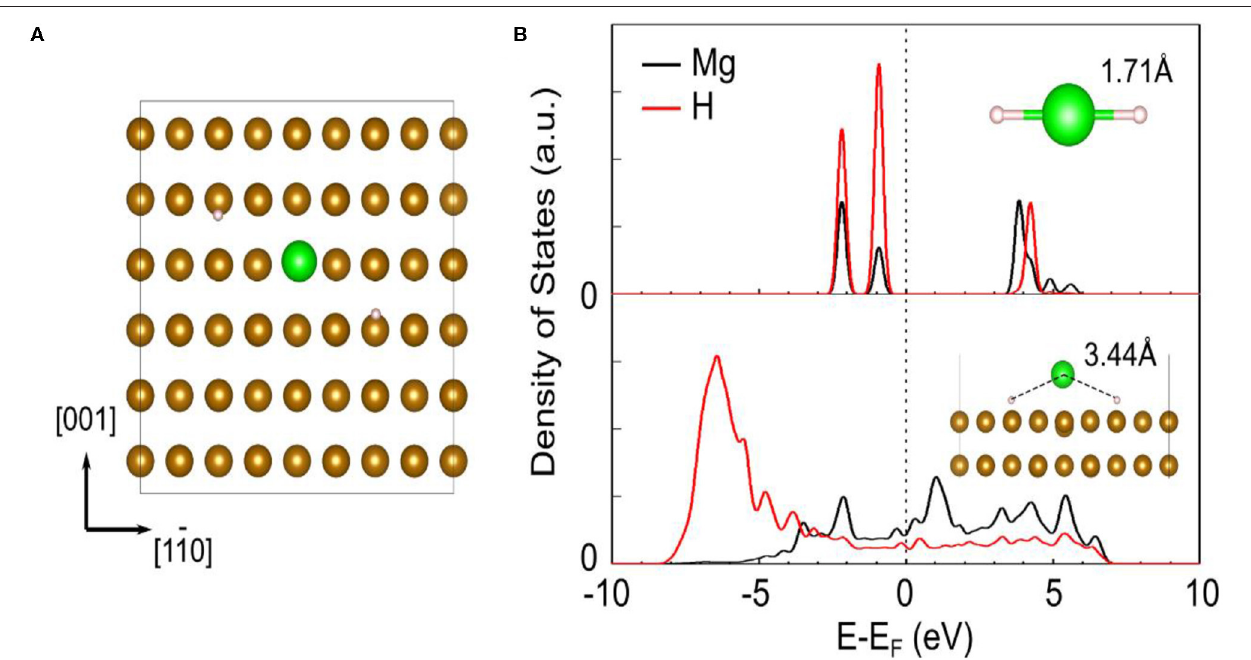
FIGURE 1 | The adsorption geometry of MgH 2 on Fe (110) surface in top view (A) . The brown, green, and white ball represent Fe, Mg, and H, respectively. The projected density of states (PDOS) of Mg and H of MgH 2 before (upper) and after (lower) adsorption on Fe (110) (B) . The Mg-H distances are shown as inset. The vertical dash line represents the Fermi energy. Reproduced from Zhang et al. (2019b) with permission from